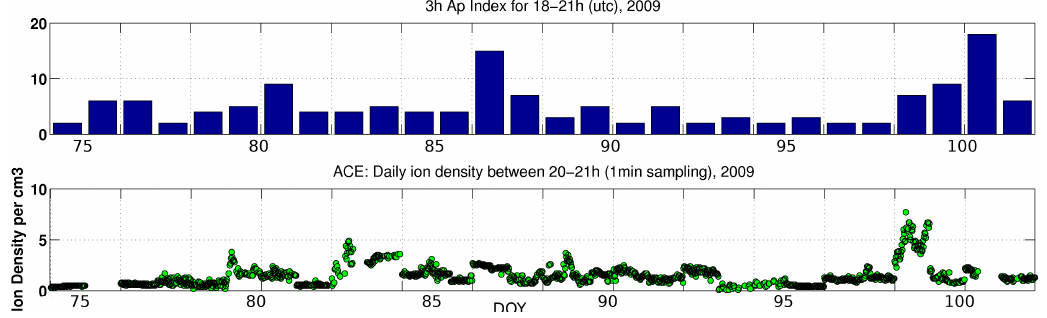
Fig. 4. Ap index (top panel) and ion density (bottom panel) measurements recorded during the DEMETER orbital transition periods above L’Aquila